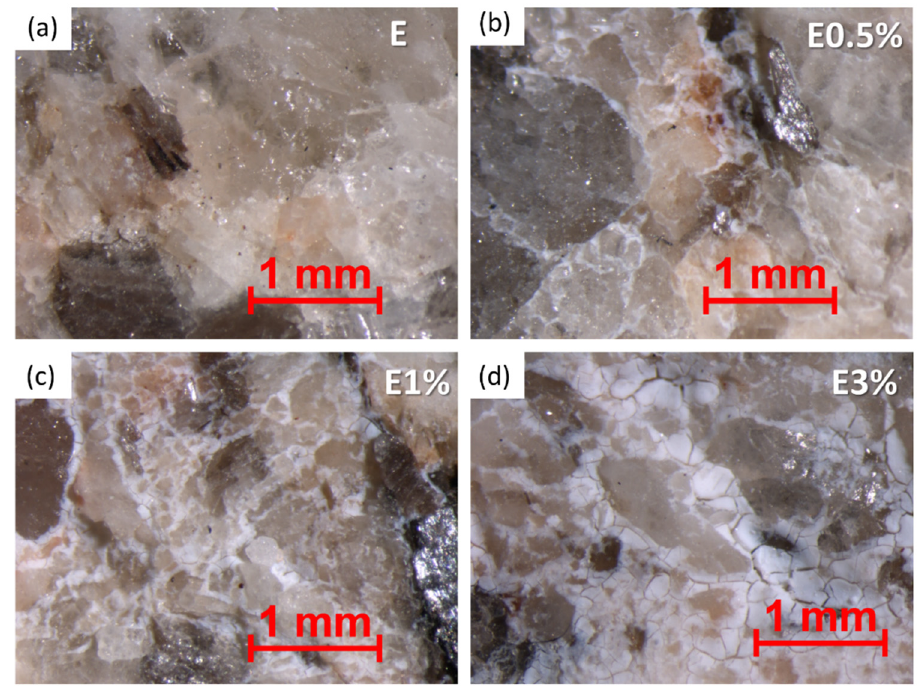
Figure 2. Micrographs taken with stereomicroscopy of the surfaces covered with the ethyl silicate-based consolidant Estel 1000 and the different TiO 2 nanoparticles concentration ( a : 0%; b : 0.5%, c : 1%, and d : 3%). Check Table 1 to understand the acronyms.